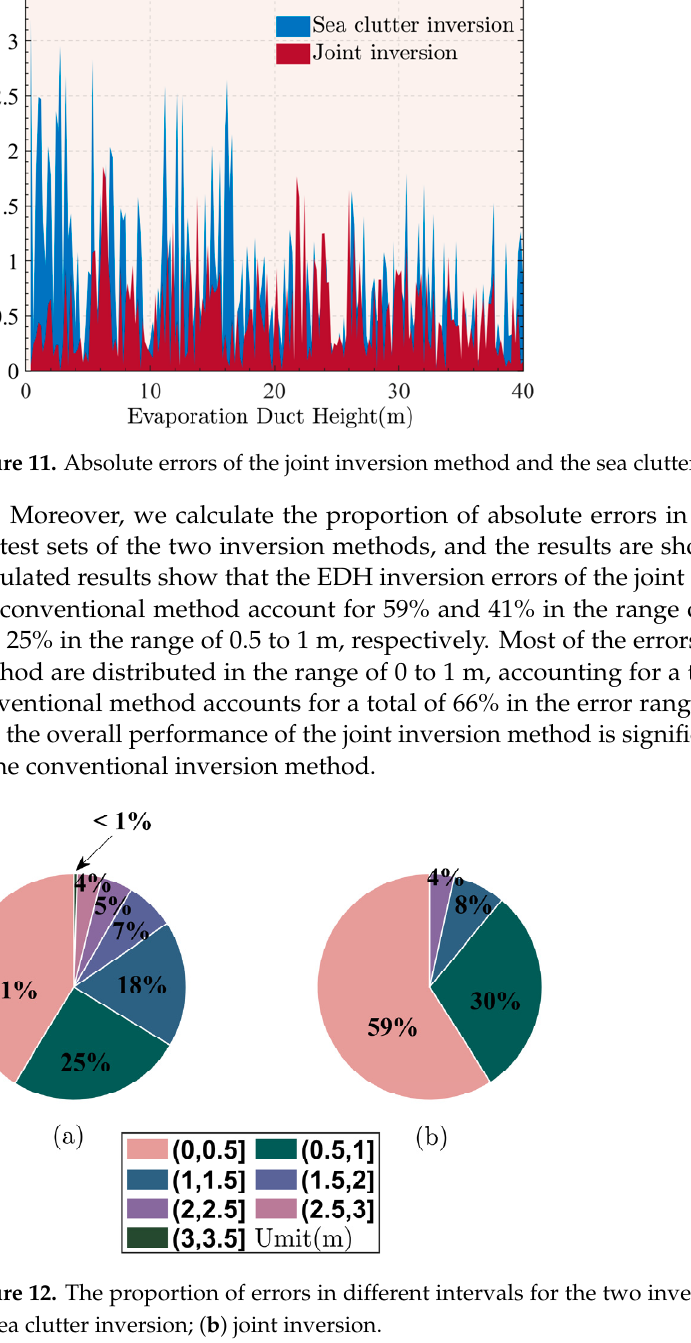
Figure 12. The proportion of errors in different intervals for the two inversion methods. Errors of ( a ) sea clutter inversion; ( b ) joint inversion.